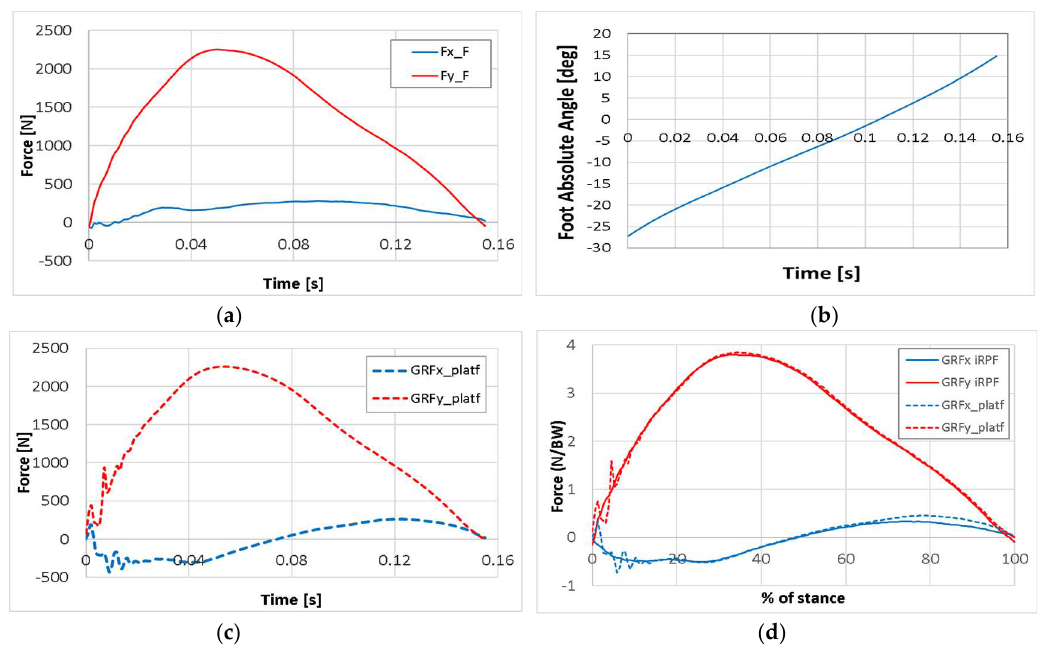
Figure 12. Validation of the Ottobock iRPF, by comparison of GRF measured with the Force Platform and with the iRPF during a running test of athlete KD2: ( a ) force components in the Foot reference system, collected from the iRPF; ( b ) absolute orientation angle of the Foot reference system obtained by the Xsens Moven suit during the step over the force platform; ( c ) GRF measured by the Kistler force platform at the passage of the athlete; and ( d ) comparison of X and Y GRF components between the force platform measurement (dotted) and the iRPF loads resolved in the Global reference system.